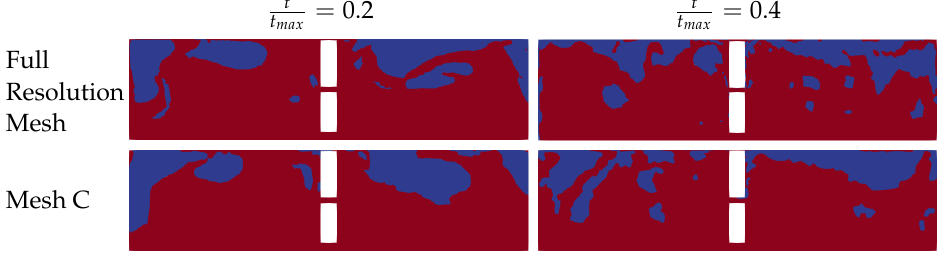
= 0.2 (left) and t = 0.4 (right) on the full-resolution mesh ( top ) t max t max